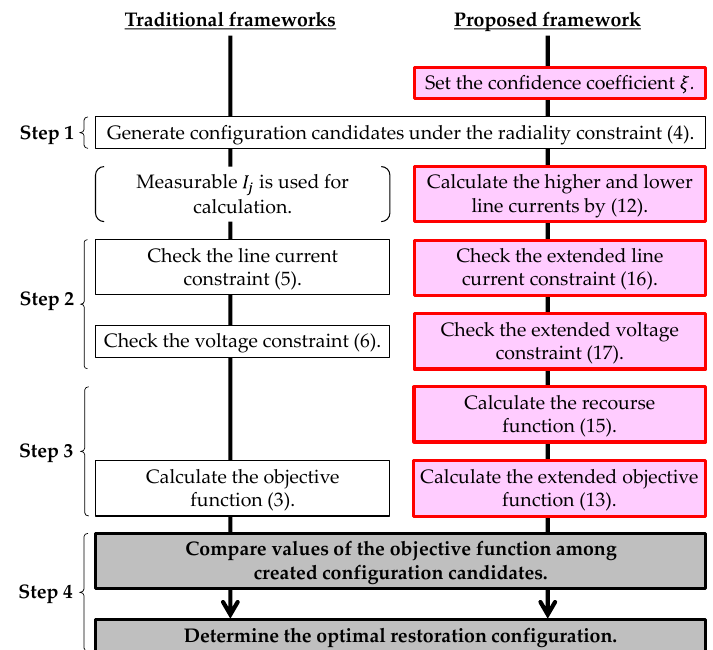
Figure 3. Procedure of the solution methods.